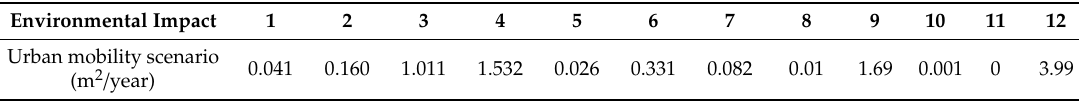
Table 8. Urban mobility scenario.